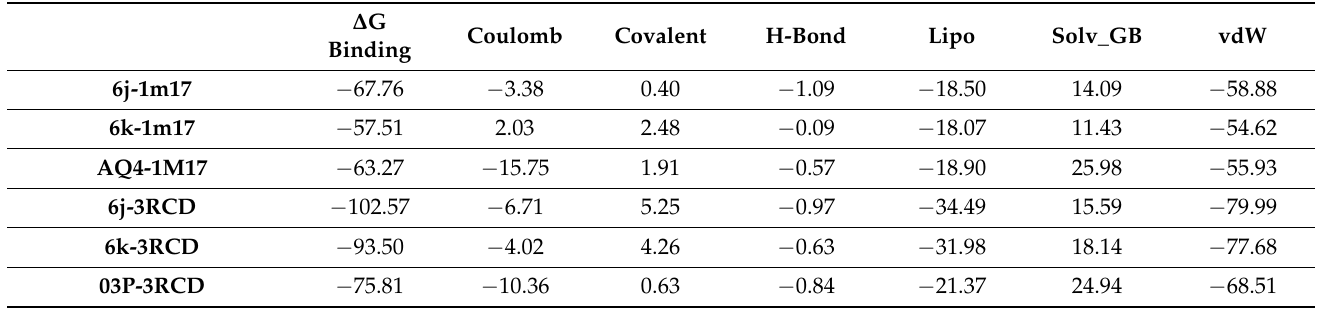
Table 8. Prime MM-GBSA energies for Ligands binding at the active sites of both EGFR (PDB ID: 1M17) and HER2 (PDB ID: 3RCD) target